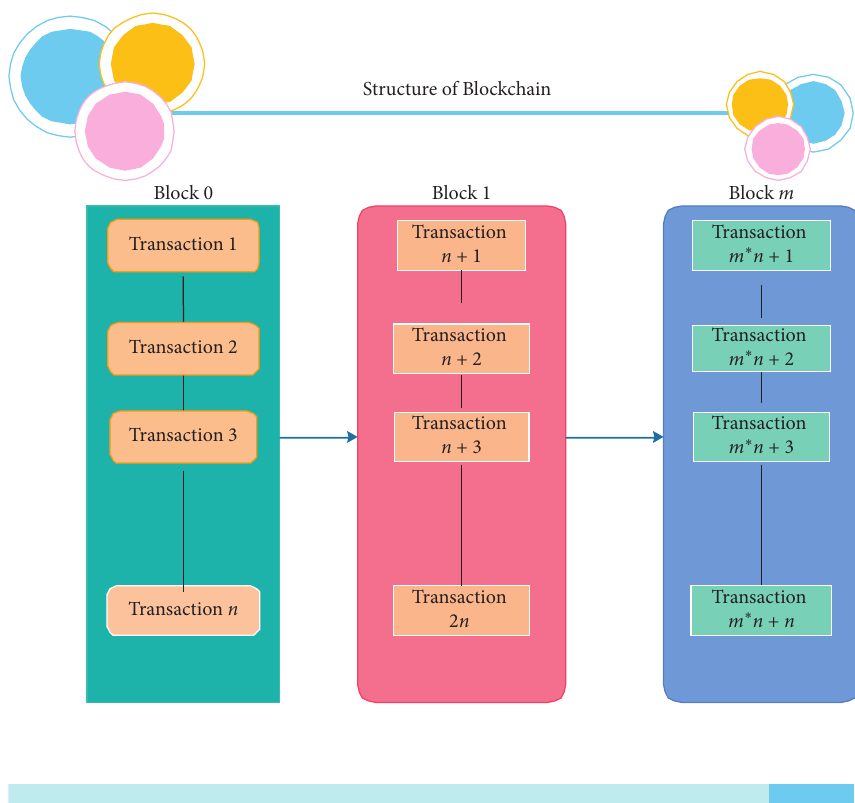
Figure 2: Structure of the